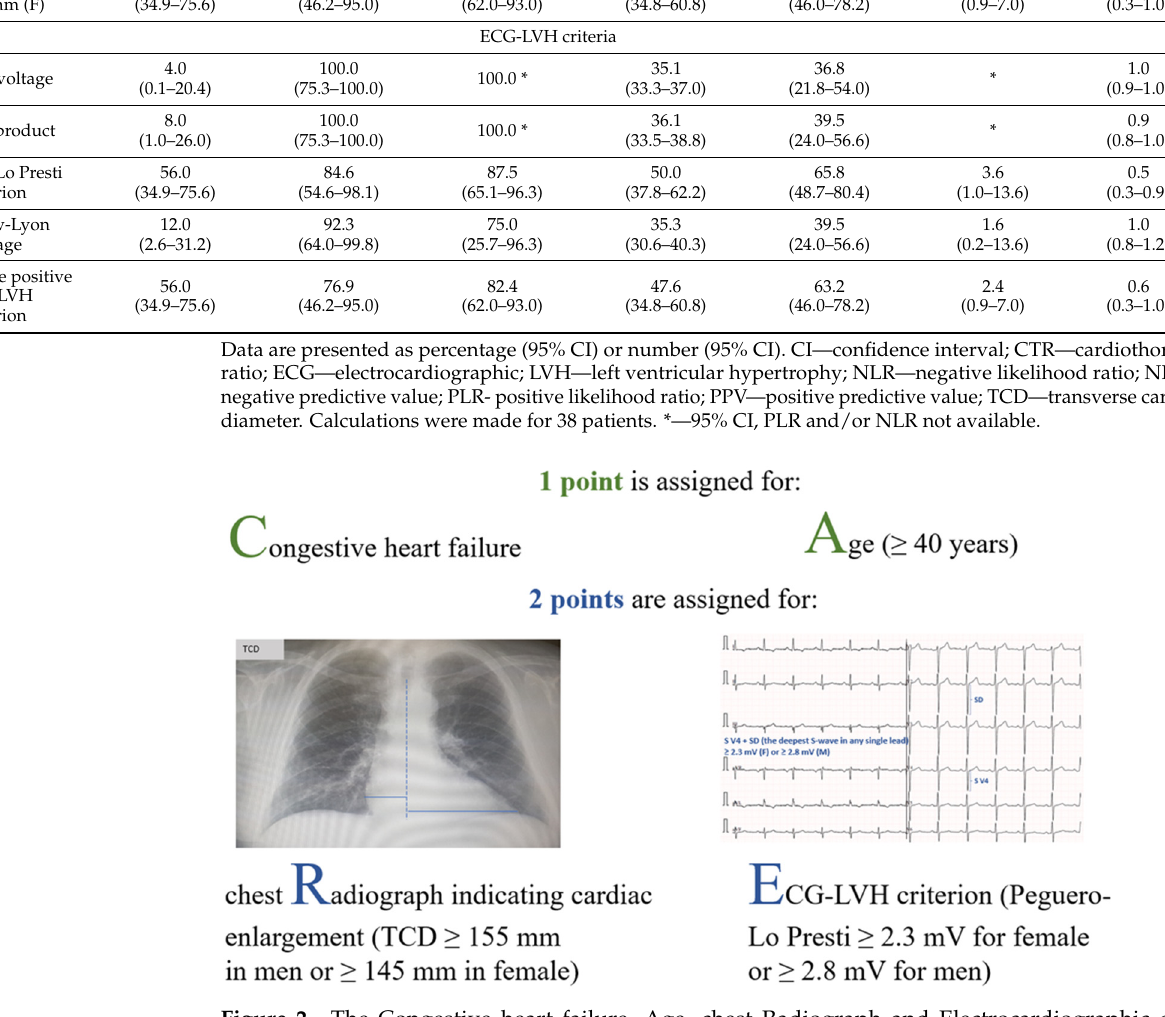
Figure 2. The Congestive heart failure, Age, chest Radiograph and Electrocardiographic data (CAR 2 E 2 ) score assessment.